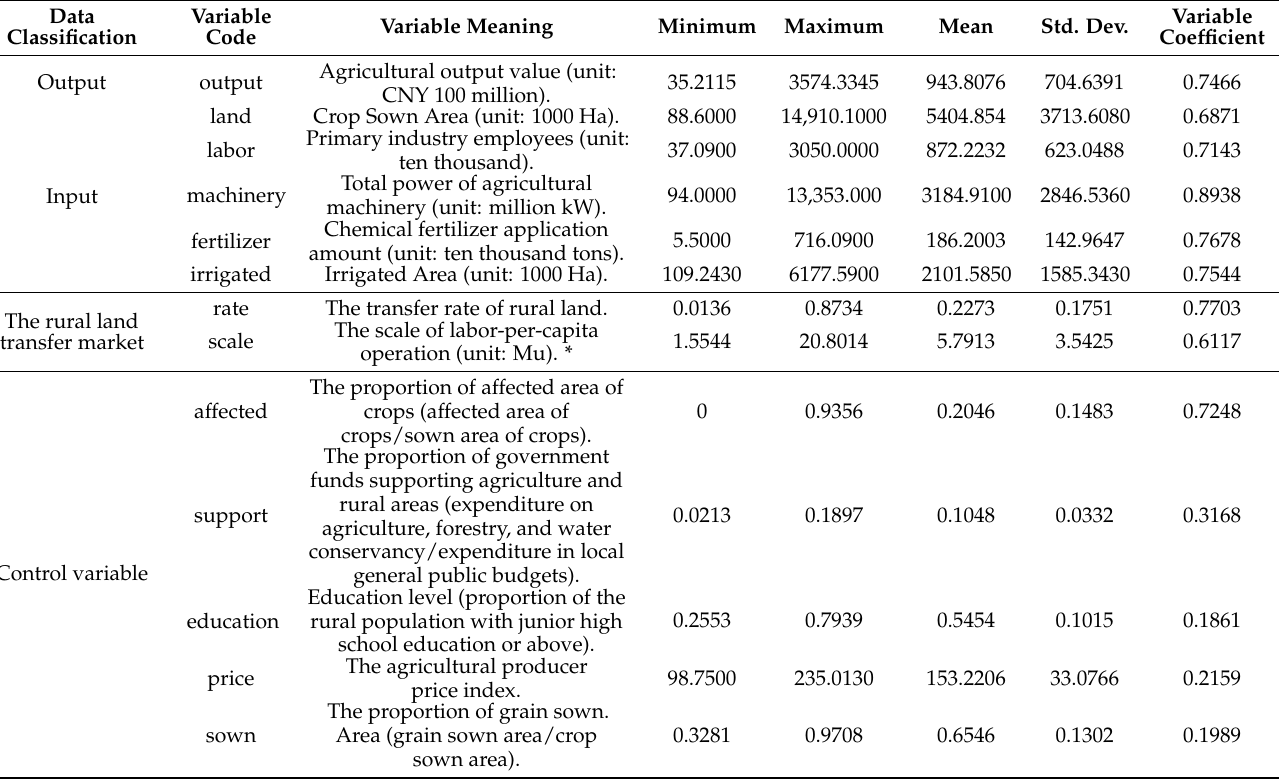
Table 1. Descriptive statistics of